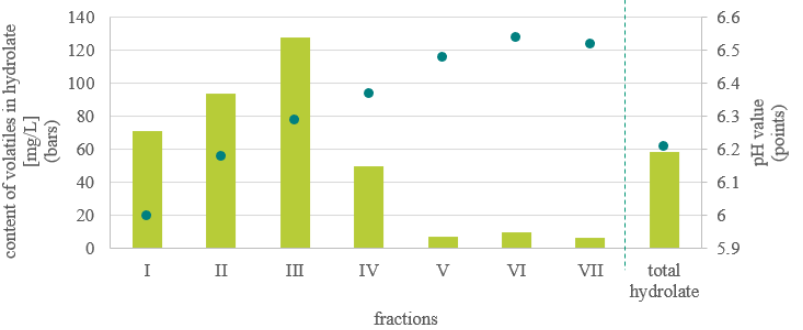
Figure 1. pH value (green bullet line) and content of volatile compounds (green bars) in hydrolate fractions and total hydrolate of the U. dioica L.